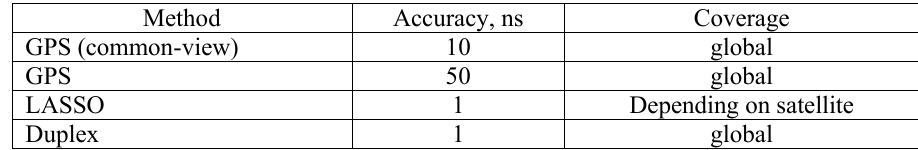
Table 2. Results analysis of the existing synchronization